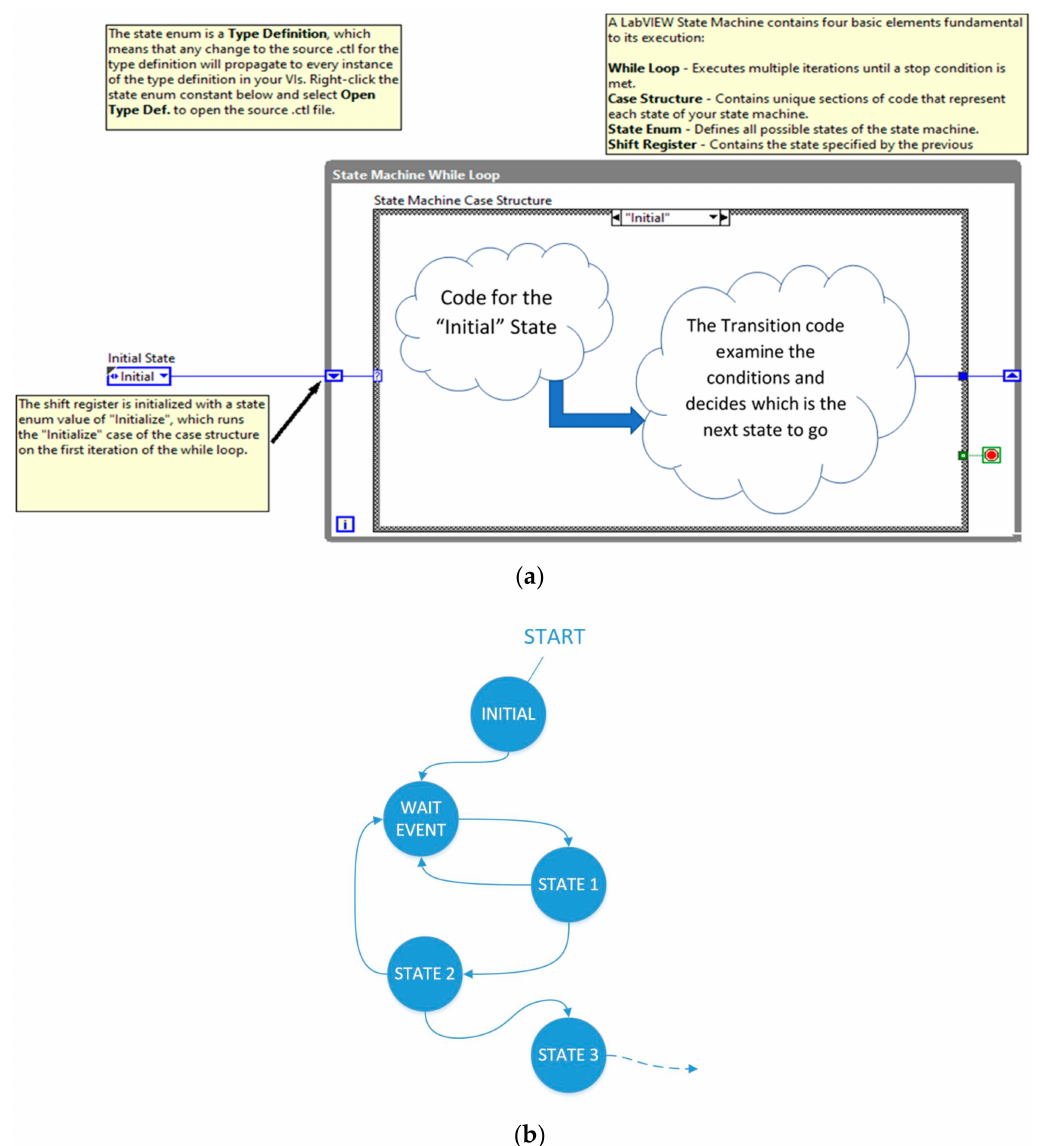
Figure 6. ( a ) State machine LabVIEW 2019 ® template; ( b ) Typical state